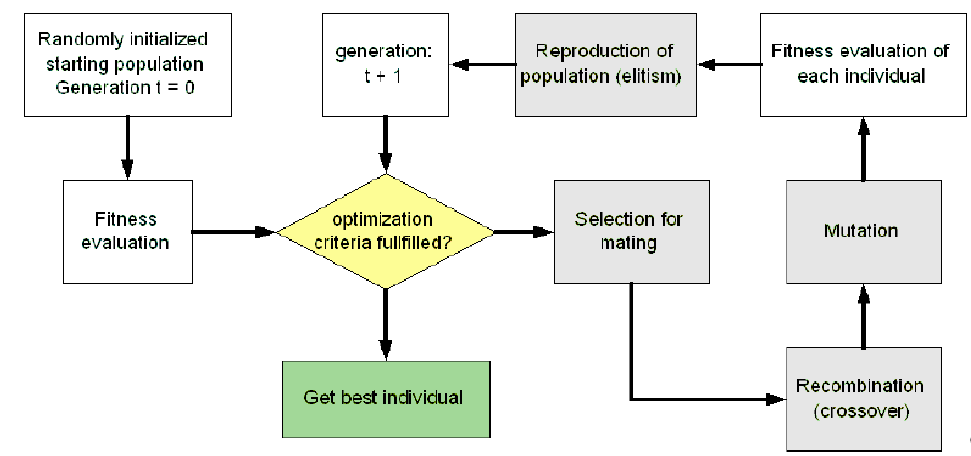
Figure 10. The general process of